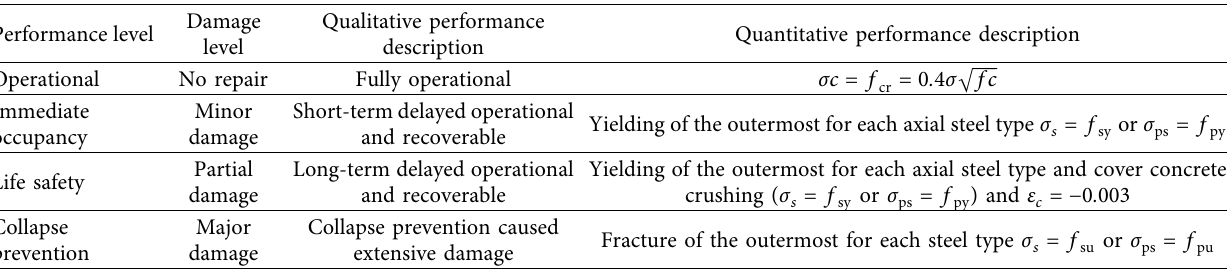
Table 3: Qualitative and quantitative performance levels for precast bridge piers.